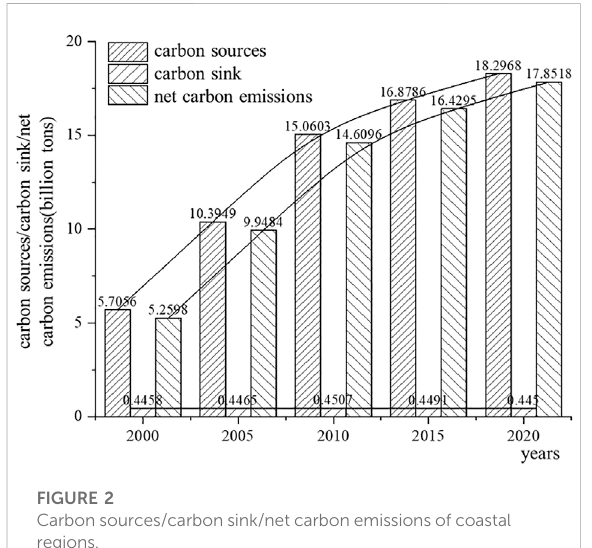
FIGURE 2 Carbon sources/carbon sink/net carbon emissions of coastal regions.